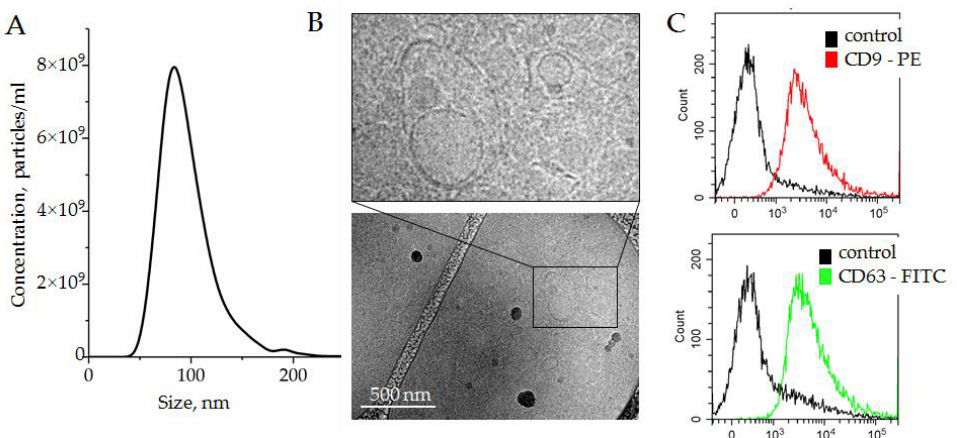
Figure 3. ( A ) Size and concentration of SEVs isolated by the two-phase polymer system from plasma and measured by NTA; ( B ) SEVs visualized by cryo-TEM; ( C ) expression of exosomal surface markers, CD9 and CD63, assayed by bead-assisted flow cytometry. SEVs were attached on the surface of latex beads by nonspecific electrostatic interactions, and then stained with fluorescent-labeled antibodies against either CD9 or CD63. Latex beads without SEVs were stained with antibodies and assayed as a negative control.